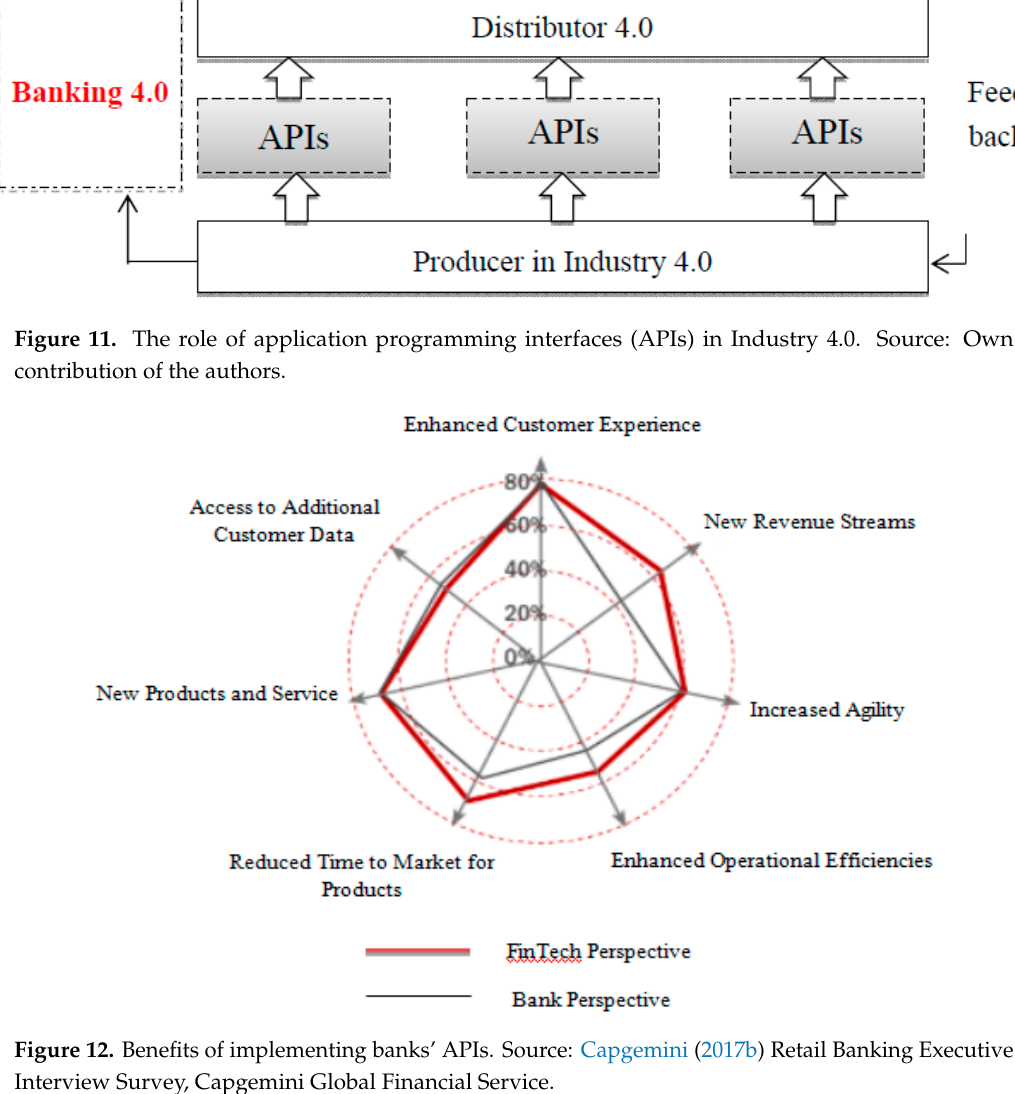
Figure 11. The role of application programming interfaces (APIs) in Industry 4.0. Source: Own contribution of the authors.